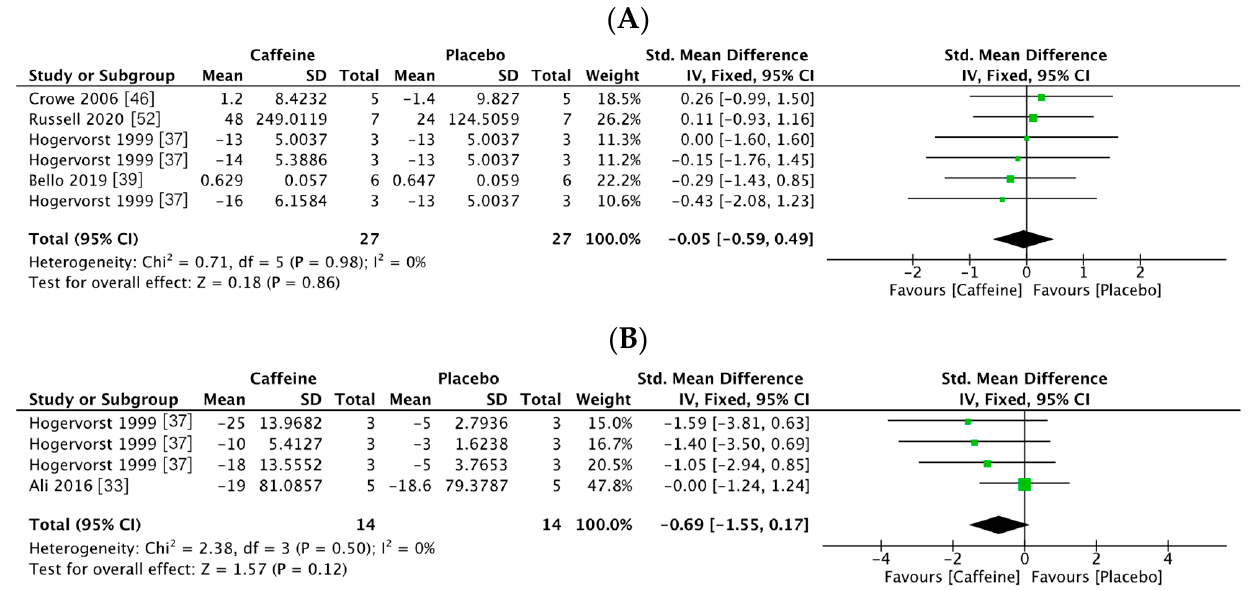
( B ) Figure 4. Forest plots of inhibitory control responses observed in athletes in conditions of supplementation with caffeine vs. a placebo. ( A ) Response accuracy; ( B ) response speed. 4. Discussion The purpose of this systematic review and meta-analysis was to summarize all of the scientific evidence available regarding the effects of acute caffeine supplementation on variables related to cognitive performance in sport. Due to the different outcome measures of the studies, the variables described below were clustered for more compre- hensive scrutiny. 4.1. Objective Measurements of Cognitive Performance